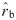
Direct range restriction (DRR): Root mean square error (RMSE) of the estimates of the predictive validity (r^b and r^pb).r^b is the estimate of the biserial correlation coefficient for an artificially dichotomous criterion variable, and r^pb is the estimate of the point-biserial correlation coefficient for a naturally dichotomous criterion variable.